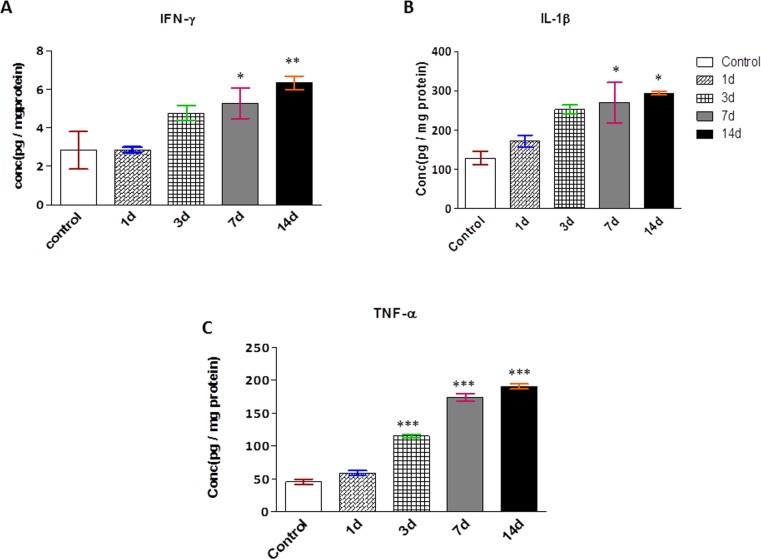
Effect of chronic hypoxia on inflammatory signaling.(A) IFN-ϒ (B) IL-1β, and (C) TNF-α. All values presented as mean ± SEM. *p<0.05 Vs. Control; **p<0.01 Vs. Control; ***p<0.001 Vs.Control.